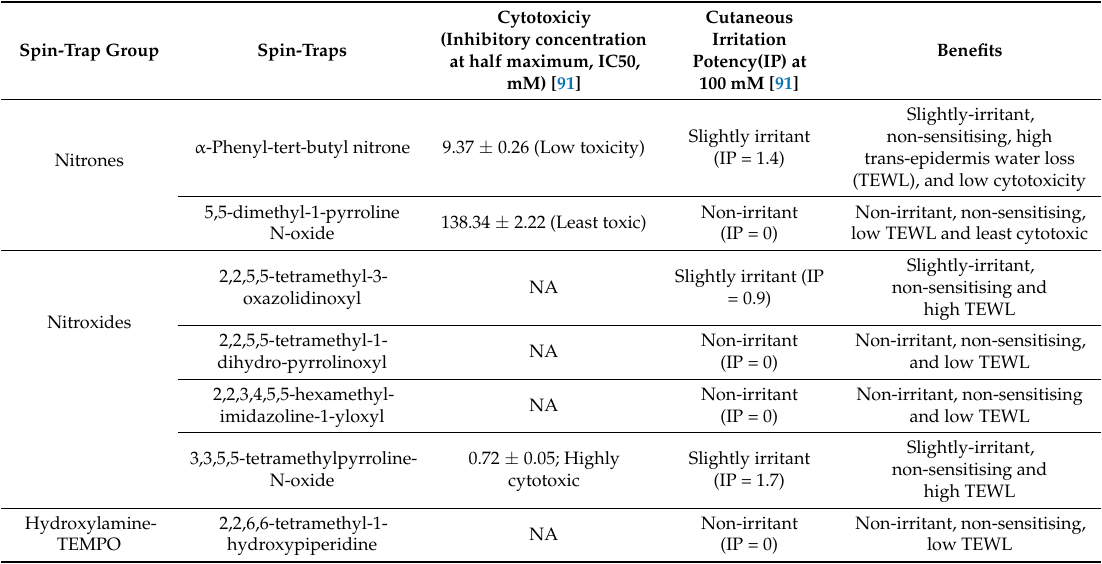
Table 3. Types of spin